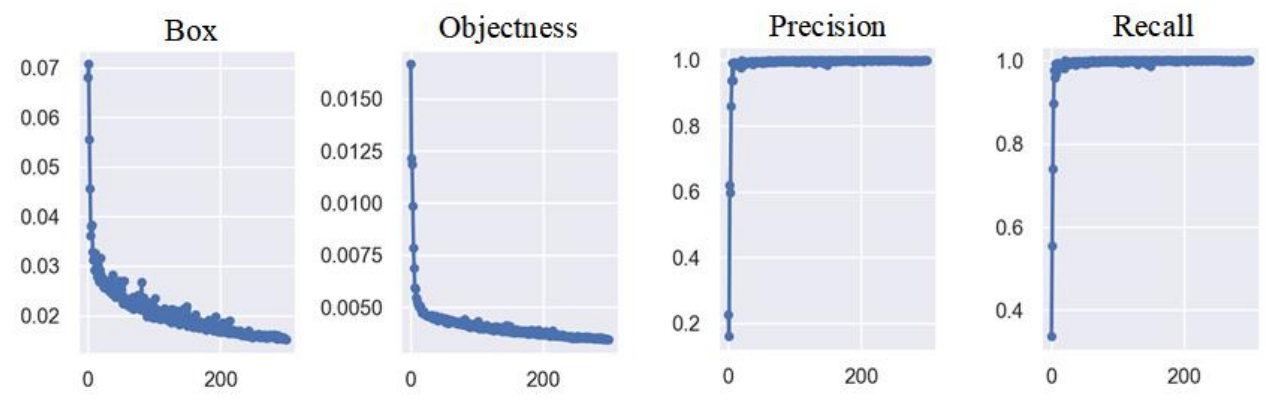
Figure 13. Visualize of